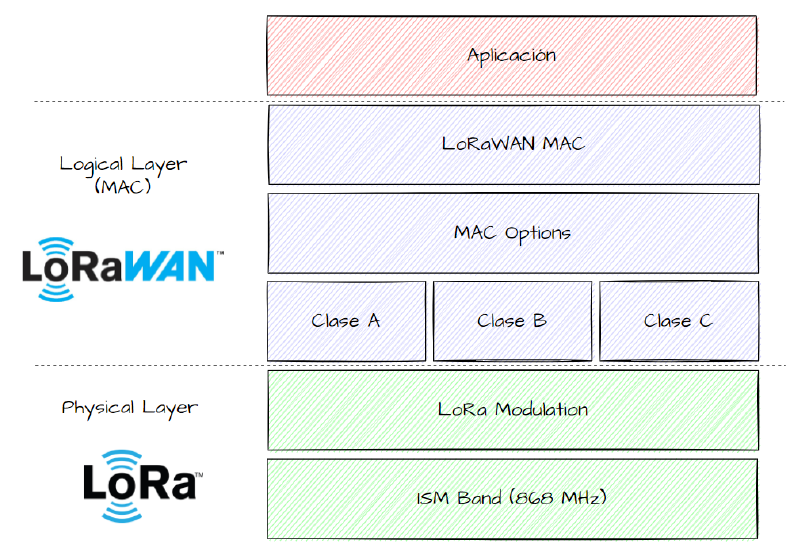
Figure 2. LoRaWAN protocol